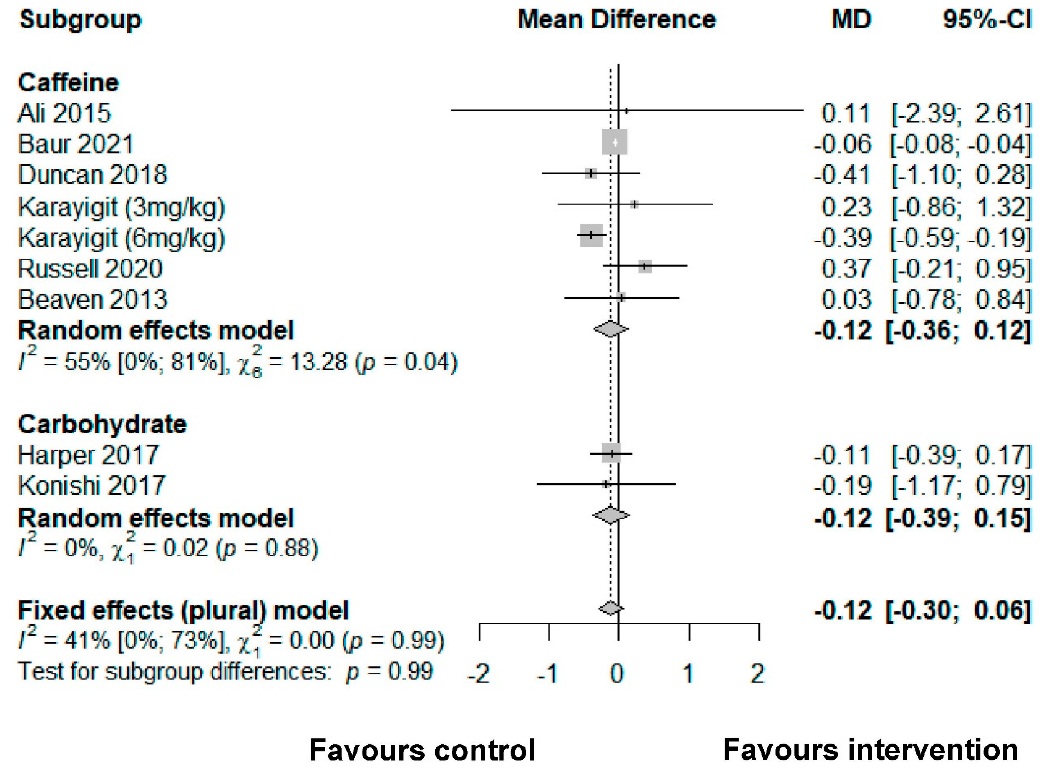
Figure 3. A meta-analysis of the effect of nutrition interventions on accuracy.